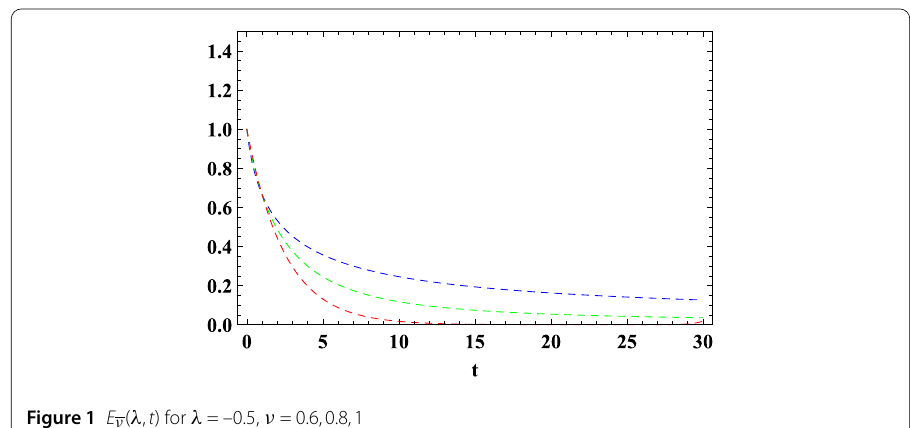
Figure 1 E ν ( λ , t ) for λ = –0.5, ν = 0.6,0.8,1